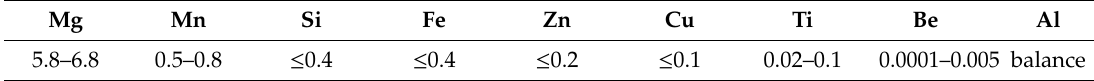
Table 1. Chemical composition of 5A06 aluminum alloy (%).